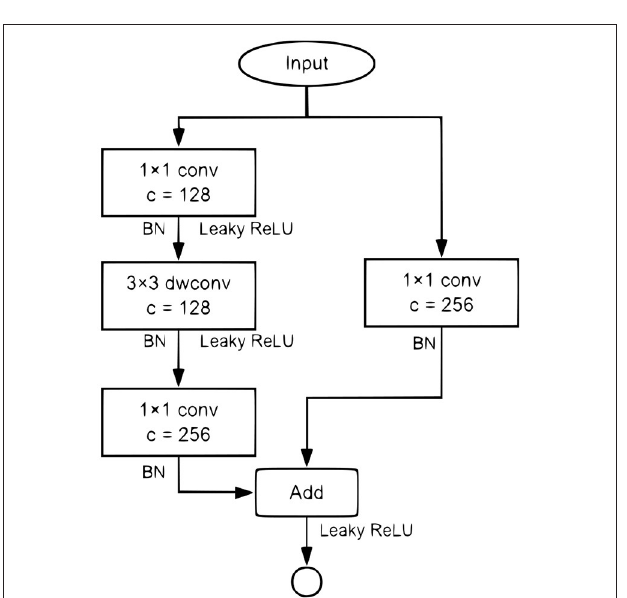
FIGURE 5 | The ResBlock in PeeleNet.